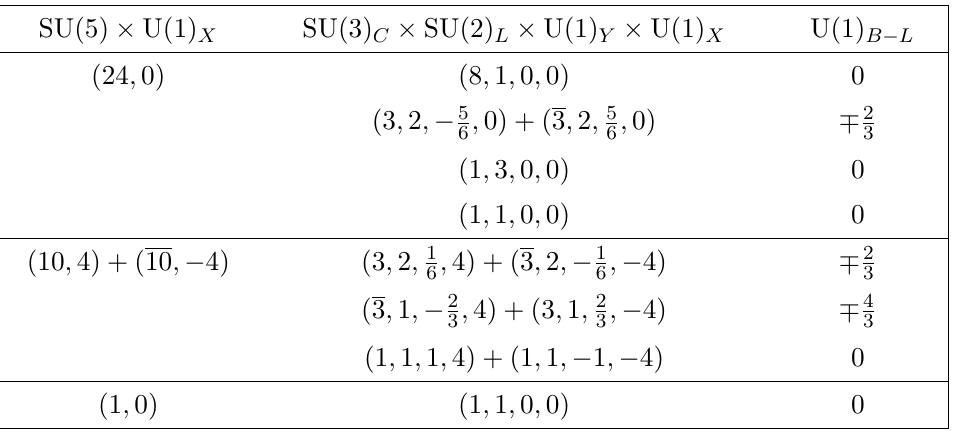
Table 1 . The decomposition of 45 -plet of